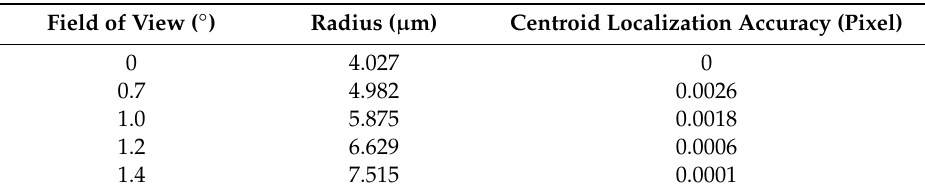
Table 5. Radii and centroid localization accuracies of di ff use spots.